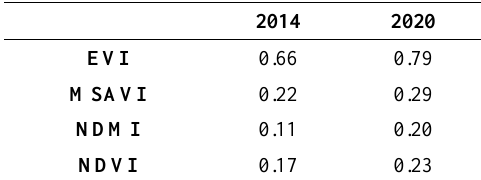
Table 2: Mean values of indices in 2014 and 2020 The time series plots of the indices show an upward trend in the values for most of the points in the study area ( Figure 2 ). The slope of trend lines for NDVI, MSAVI and NDMI are similar, while the slope of the EVI trendline is steeper. The positive slope values support the interpretation of growth in vegetation. The slopes of the trendlines for indices were plotted for the damage and recovery period ( Figure 3 and Figure 4 ). The horizontal axis for the slope of the trend lines corresponds to the data points. These said points were arranged according to their locations along the coastline from west to east.